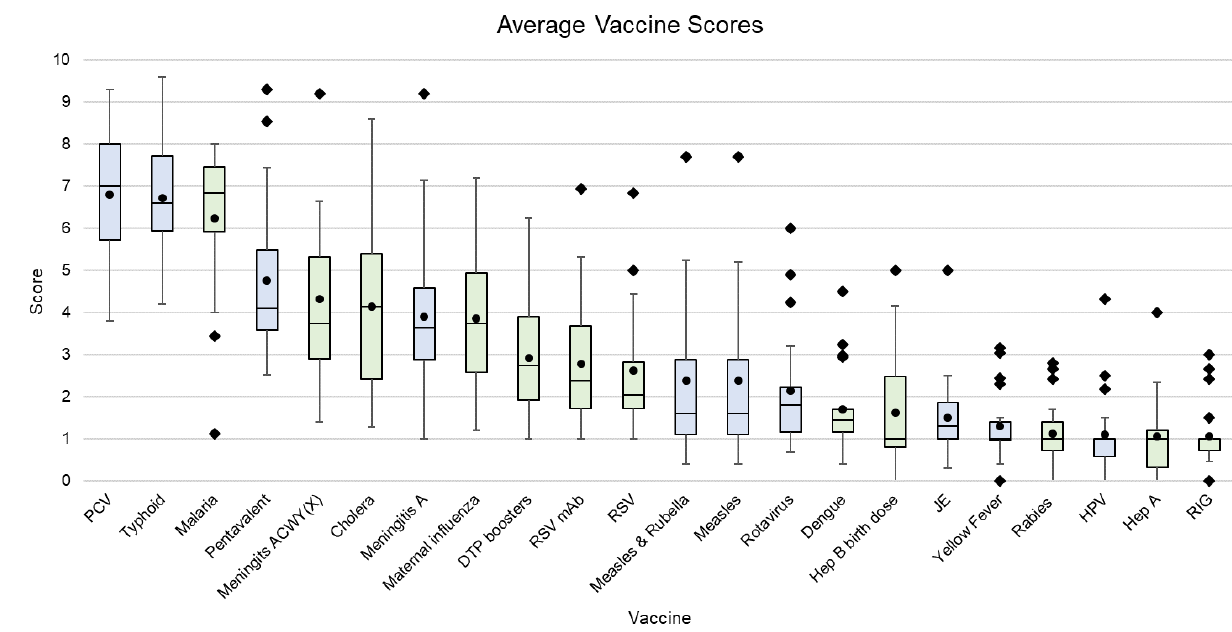
Figure 2. Overall vaccine impact on AMR as estimated by experts, boxplots. 1= least effect of vaccine and 10 = greatest effect of vaccine on AMR Lower error bar= minimum value; lower bound of the box= lower quartile range; black line inside the box=median; upper bound of the box=upper quartile range; upper error bar= maximum value; circle=mean; square = outlier (defined as over 1.5*interquartile range from the 1st or 3rd quartile) Blue shading = Gavi portfolio vaccines; Green shading = VIS candidate vaccines PCV – pneumococcal conjugate vaccine; Pentavalent vaccine (diphtheria, pertussis, tetanus, hepatitis B and Haemophilus influenzae type B); DTP – diphtheria, tetanus & pertussis; RSV – Respiratory syncytial virus; mAb - monoclonal antibodies; Hep B – Hepatitis B; JE – Japanese encephalitis; HPV – Human papillomavirus; Hep A – Hepatitis A; RIG – Rabies